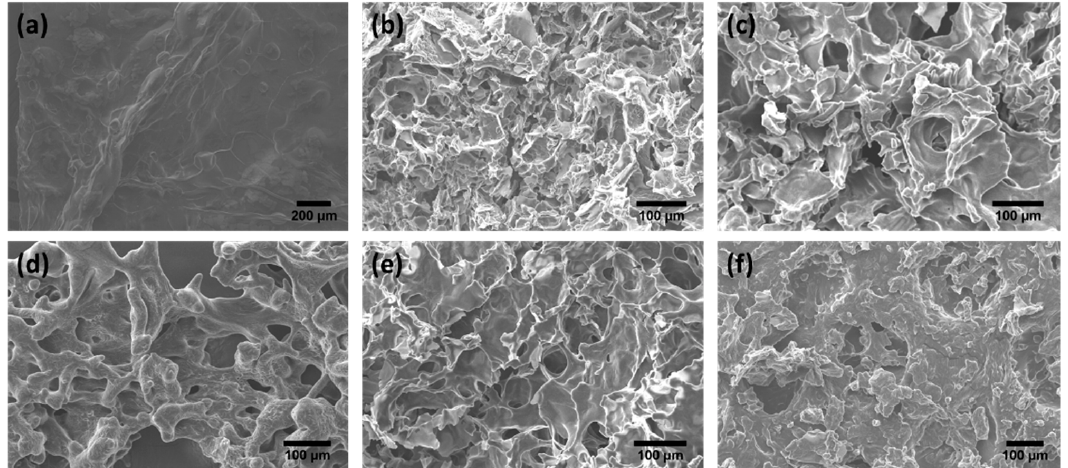
Figure 4. Cross-sectional scanning of different hydrogels from SEM images after the freeze-drying process, including single networks of ( a ) 1.5% w/v SA with calcium ion crosslinked and ( b ) 15% w/v PF127; and IPN network hydrogels composed of PF127/SA w/v of ( c ) 15/0.25, ( d ) 15/0.5, ( e ) 15/1.0, and ( f ) 15/1.5.